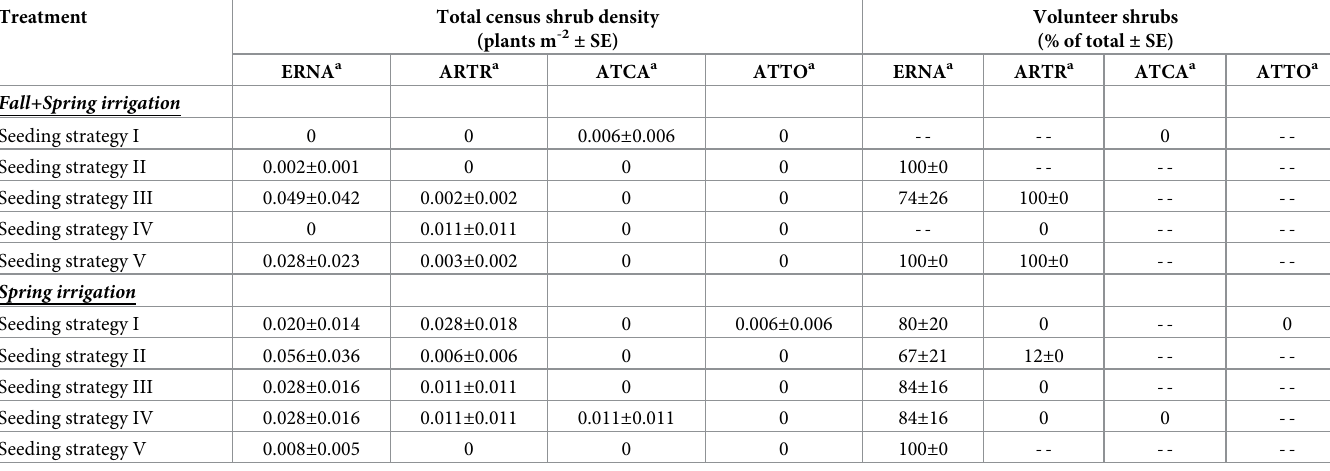
Table 4. Total shrub density (and % volunteer) in the South Field in May